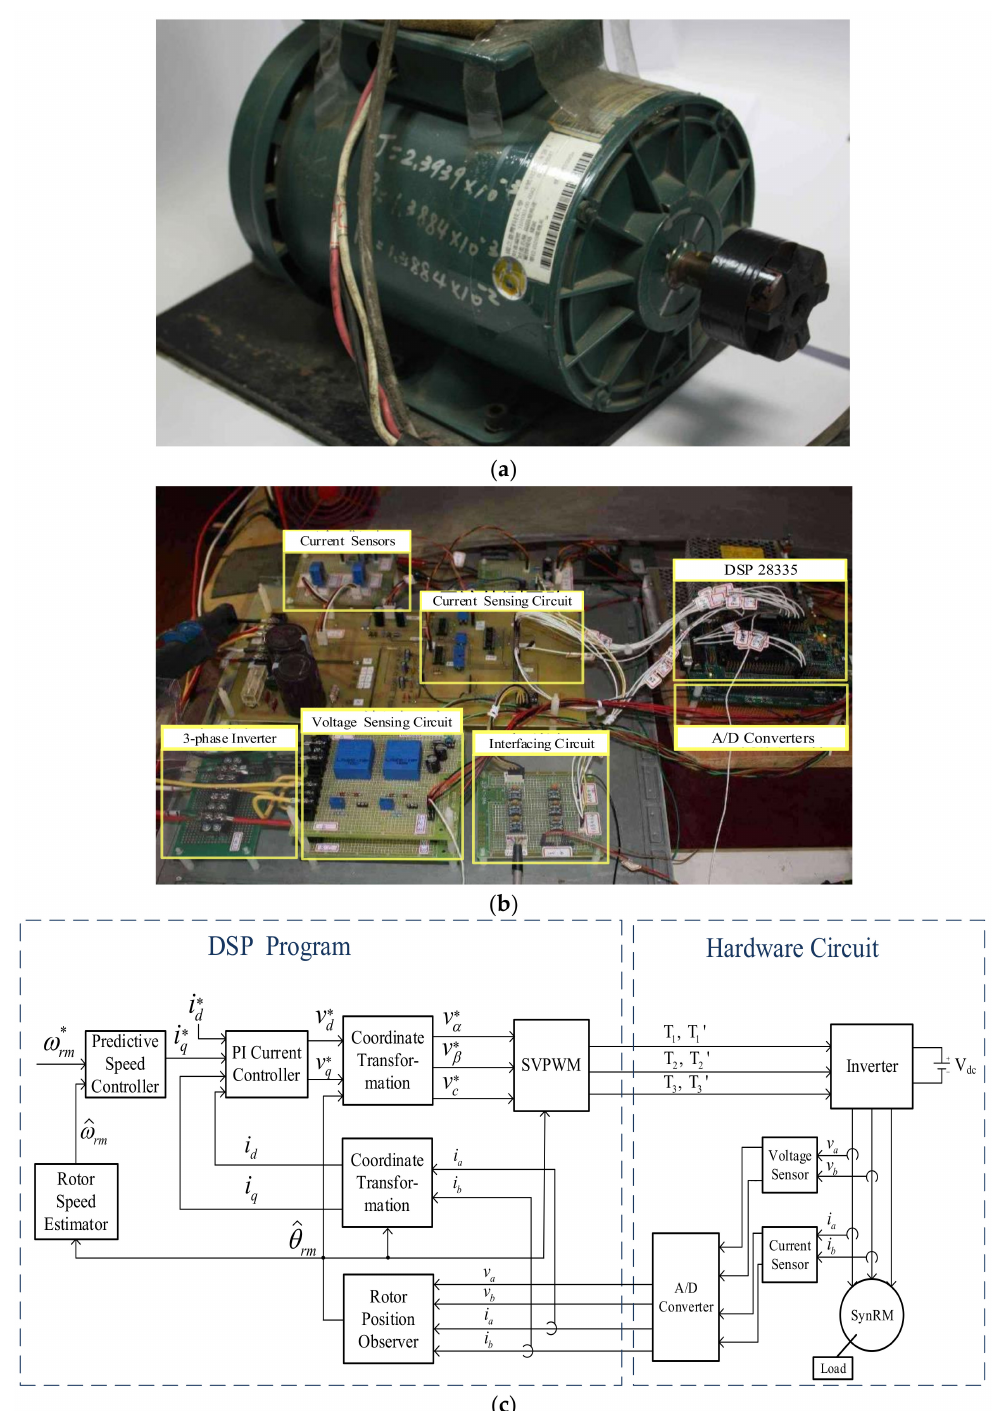
Figure 5. Implemented system. ( a ) Motor; ( b ) circuits; ( c ) block